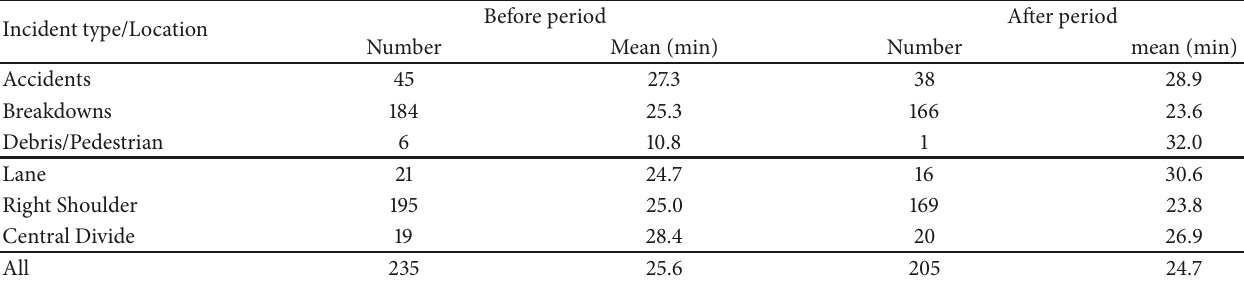
Table 1: The basic information of all available traffic incidents.